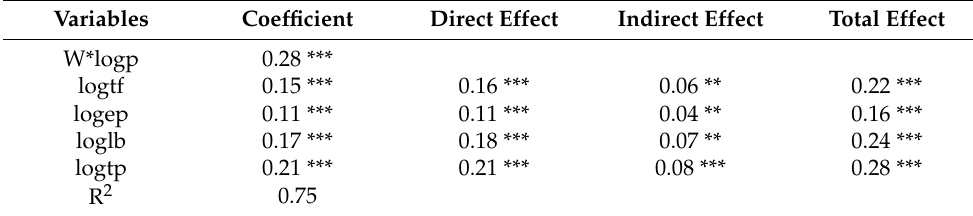
Table 6. Results of the SLM with spatial and time fixed effects for the eastern region in China. Variables